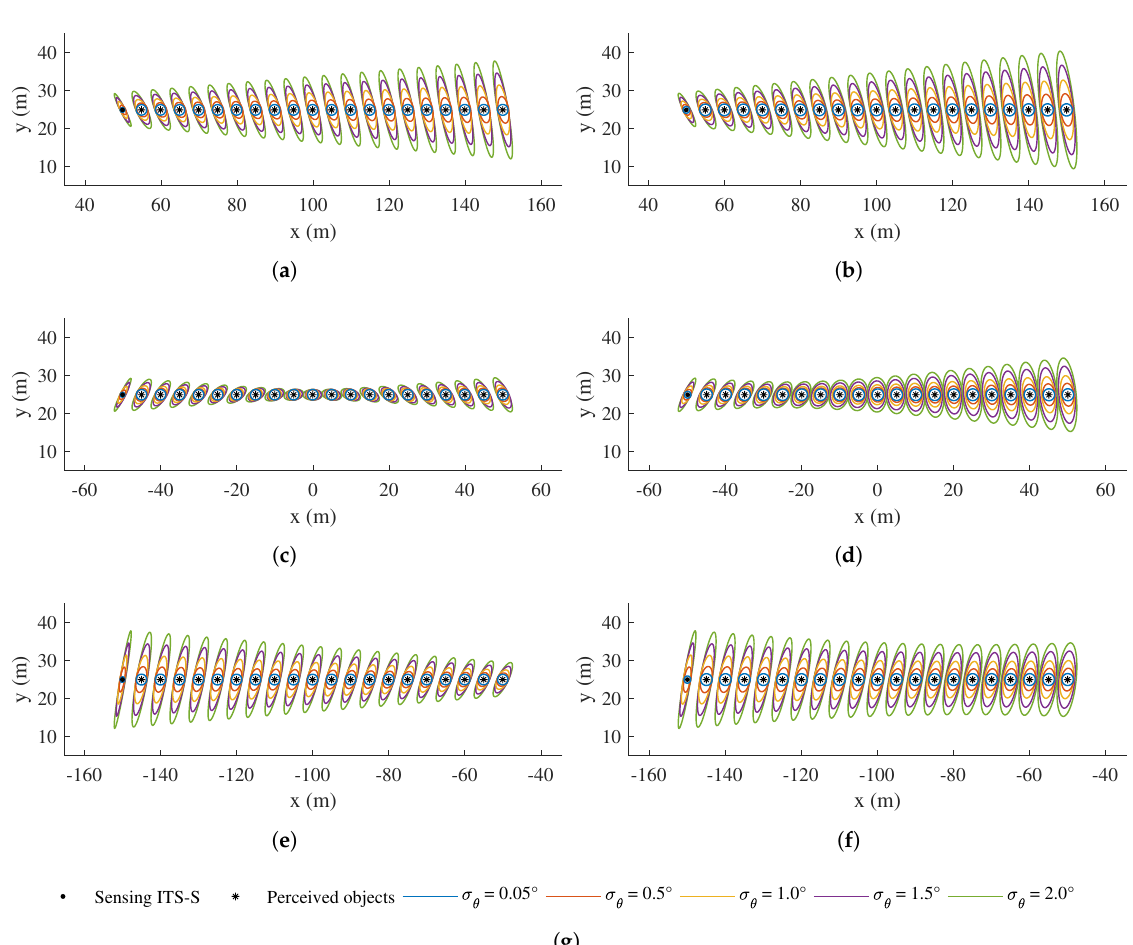
Figure 11. Confidence ellipses of perceived objects transformed to the local frame of the receiving CAV in Test 1 , where dif- ferent heading estimate standard deviations are tested for CAV(s). As the receiving CAV moves, ( a , c , e ) show the results at different relative positions between IRSU and the receiving CAV, while ( b , d , f ) present the results for the V2V case. In each subfigure, the first object on the left represents the position of the sensing ITS (visualised as a black dot) after being transformed to the receiving CAV’s local frame, while its perceived objects are denoted by black star markers. The receiving CAV sits at the origin in each subfigure. Each ellipse represents 95% of position estimate